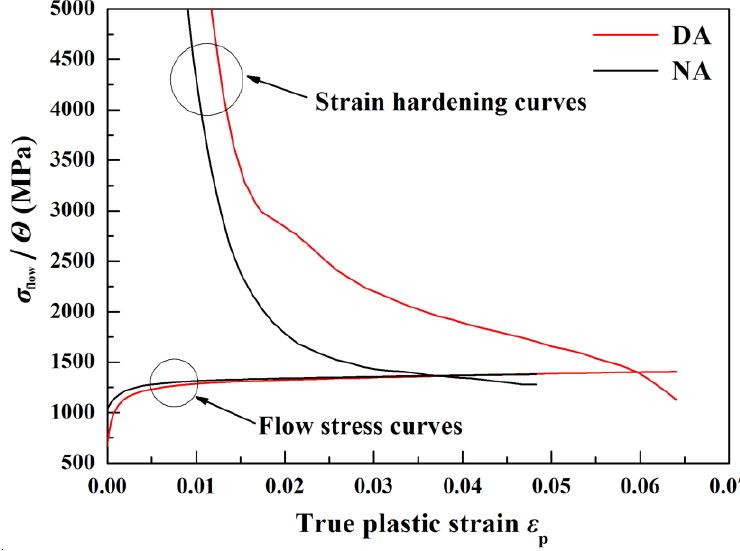
Figure 4. The flow stress and strain hardening curves of the alloy under different aging conditions.